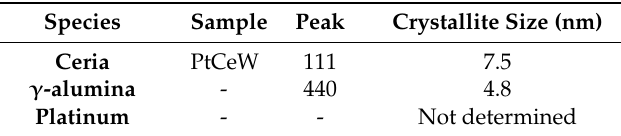
Table 2. Crystallite sizes.